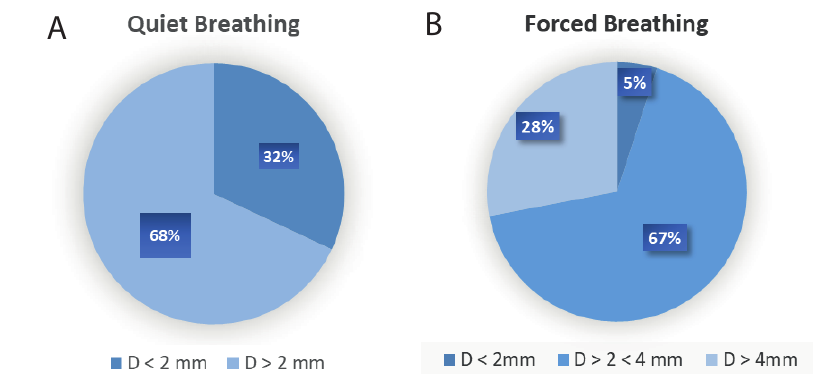
Figure 5. Deflection (D) in mm of the lateral nasal wall in quiet breathing and forced